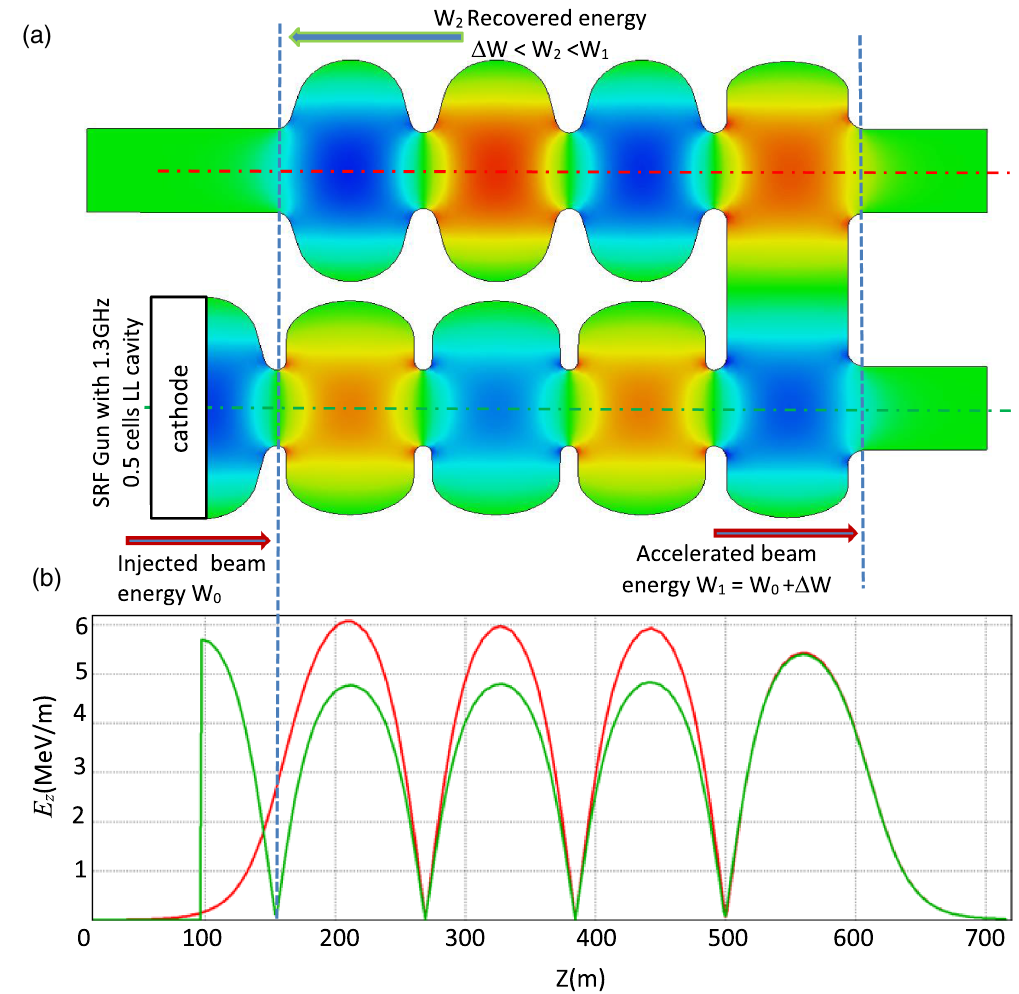
FIG. 6. (a) Schematic of the SRF injector and SRF cavity and contour plot of the operating field. (b) The dependence of the absolute value of the accelerating field ( E z ) along the longitudinal coordinate z on both axes and comparison of the dependence with the schematic shown in